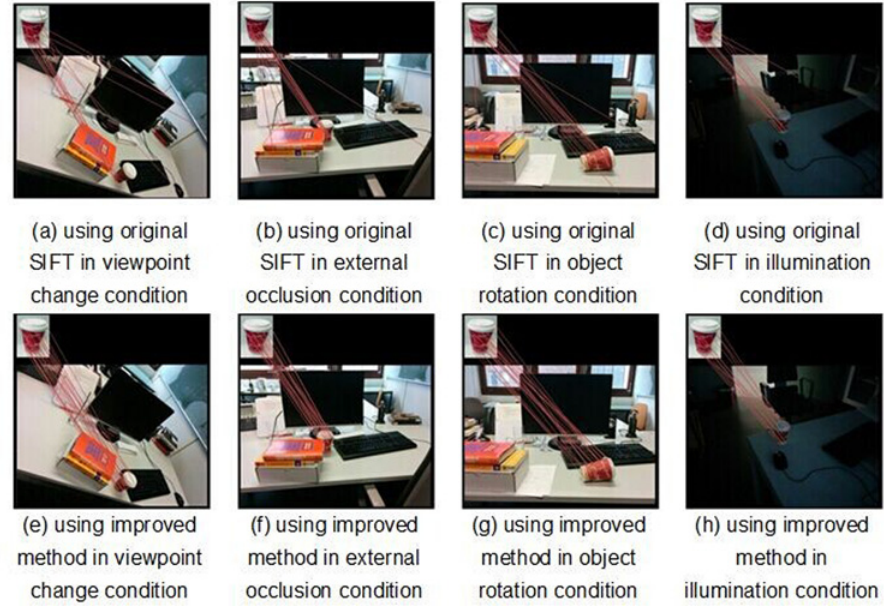
Fig 9. The result of the object recognition based on the original SIFT algorithm and the improved method.